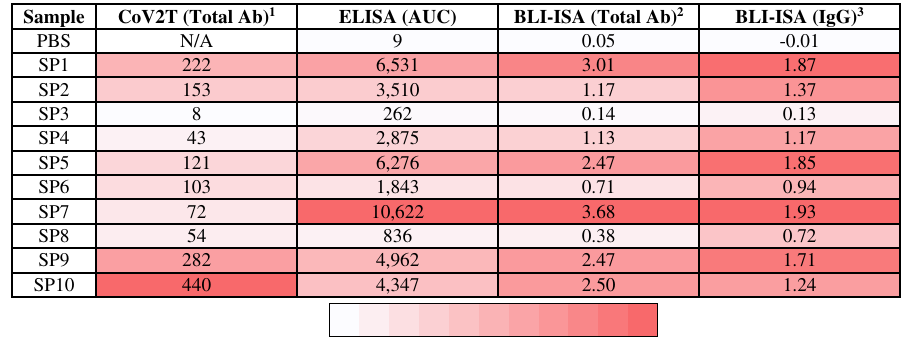
Table 1. Comparison of antibody reactivity assays with SARS-CoV-2 RBD antigen. 1 CoV2T (Total Ab) was determined previously with an Anti-SARS-CoV-2 Total test (Ortho Clinical Diagnostics). 2 BLI-ISA (Total Ab) data was collected with 1:8 diluted plasma. 3 BLI-ISA (IgG) data was collected with 1:16 diluted